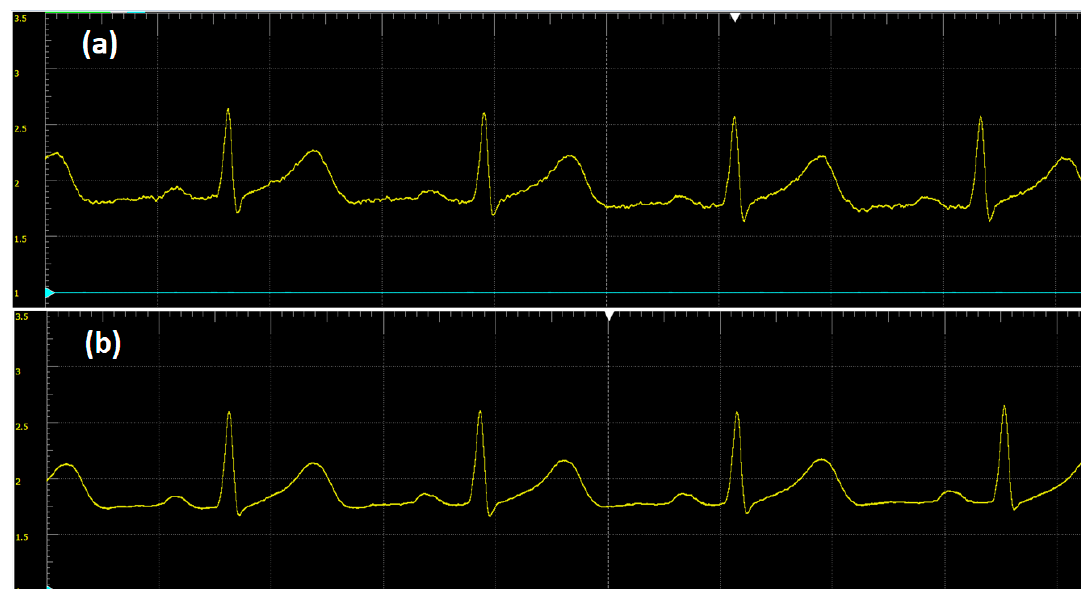
Figure 13. Comparison between AD8232 and AD8233 on a breadboard circuit using a male volunteer ECG signal. ( a ) Signal obtained from the AD8232 microchip on a breadboard circuit. ( b ) Signal obtained from the AD8233 microchip on a breadboard circuit. Oscilloscope hardware: 14-bit Analog Discovery with 500 mV/div amplitude and 290 ms/div in time base; software is Waveforms. Observe the improvement for the AD8233 output signal in ( b ).